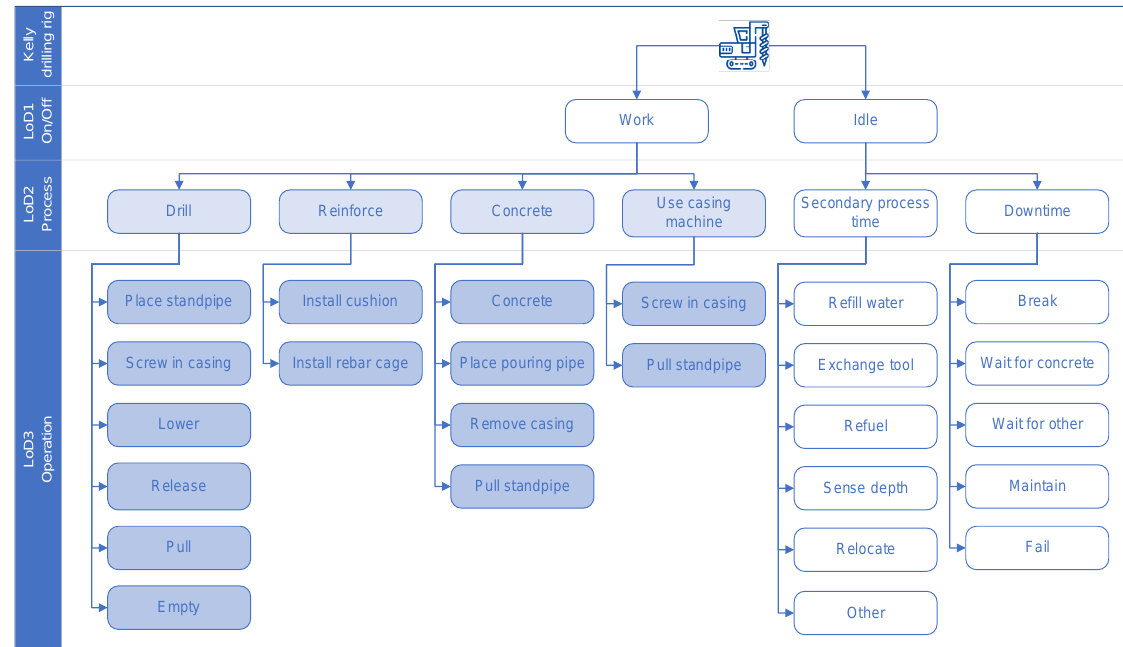
Figure 5. Overview of the LoDs (white: LoD1; light blue: LoD2; and blue: LoD3).